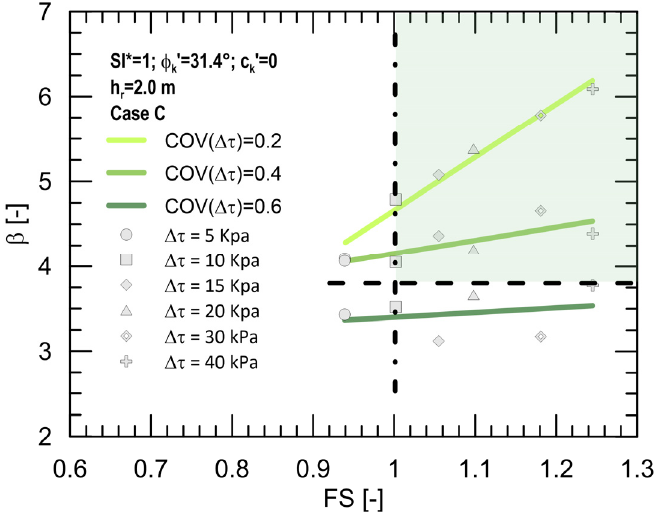
(cid:48) = 31.4 ◦ , h r = 2 m and seismic case k